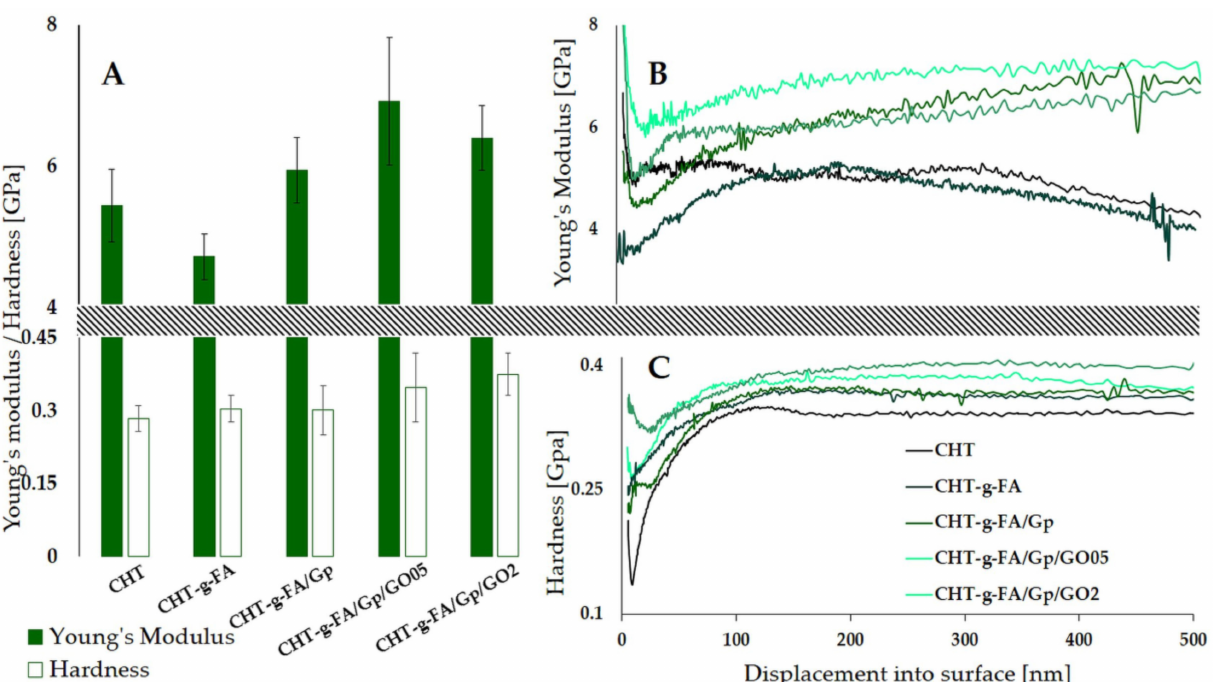
Figure 5. Influence of copolymerization, crosslinking and GO compositing on the nanomechanical properties of CHT formulations up to a maximum depth of 500 nm: ( A ) representative Young’s modulus and hardness values at 100 nm displacement into surface; ( B ) Young’s modulus as a function of the indentation depth; ( C ) hardness as a function of the indentation